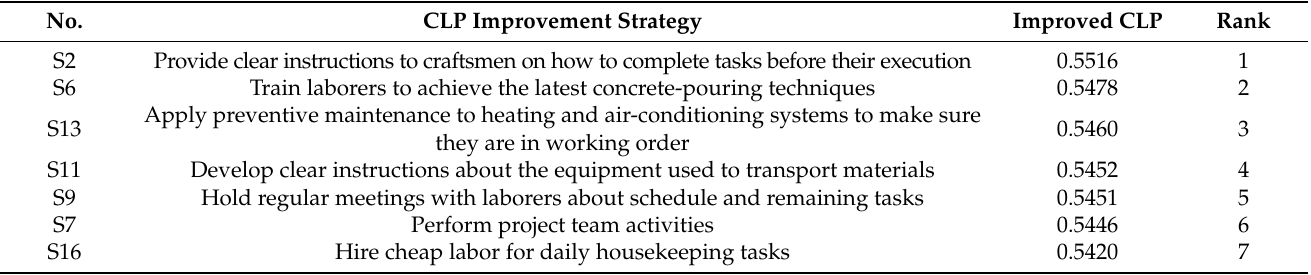
Figure 8. Flow chart showing process of determining improvement strategies’ impact on CLP.